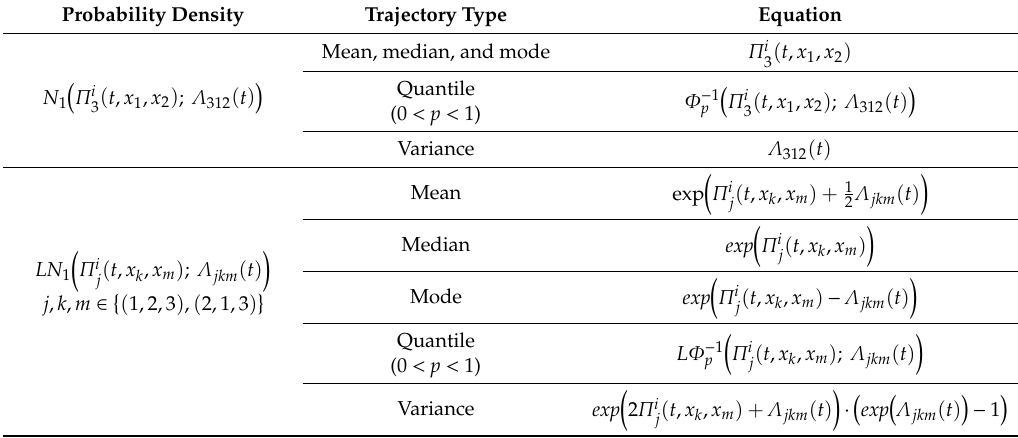
Table 5. Conditional mean, median, mode, p -quantile (0 < p < 1), and variance trajectories with two